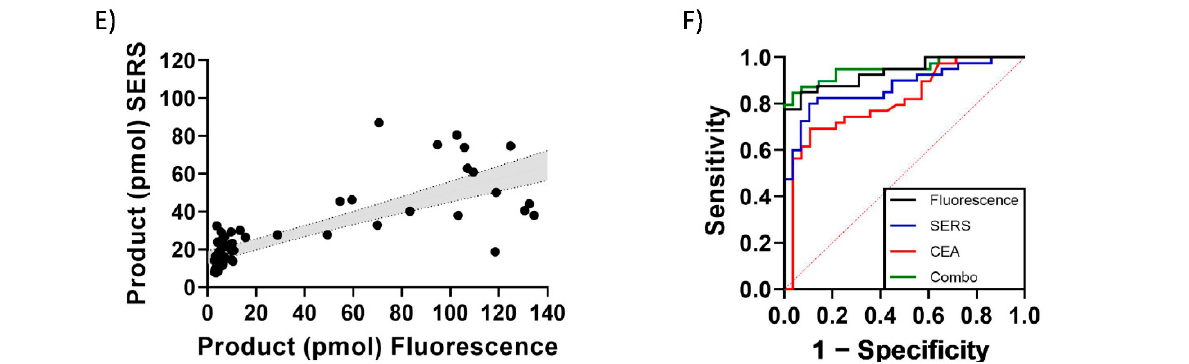
Figure 6. Clinical sample results from a retrospective cohort of 69 pancreatic cyst fluid samples with known clinical diagnoses. ( A ) The measured mass of pepsinogen C according to commercial ELISA kit. ( B ) ROC curve of ELISA measurement of pepsinogen C mass to distinguish mucinous from non-mucinous pancreatic cysts (AUC = 0.873, 95% CI 0.794–0.900). ( C ) Measured product formation calculated from fluorescence measurement of clinical samples. ( D ) Measured product formation calculated from SERS measurement of clinical samples. Sample measurements are paired and both ( C , D ) are divided into respective diagnosis category as indicated on the x-axis. ( E ) Correlation of product formation between SERS and fluorescence measurements from paired reaction samples. The grey area is the 95% confidence interval from a linear regression analysis with a slope = 0.348 and R 2 = 0.614. Every measurement represents a single reaction and sample. ( F ) ROC curve of clinical samples diagnosed according to the gastricsin activity assay using the product formation calculated from fluorescence (black, AUC = 0.936, 95% CI 0.882–0.990) or SERS (blue, AUC = 0.873, 95% CI 0.791–0.956), in comparison with clinical CEA measurement (red, AUC = 0.812, 95% CI 0.707–0.918) and a combination of all three (green, AUC = 0.950, 95% CI 0.900–1.000). **** = p < 0.0001 according